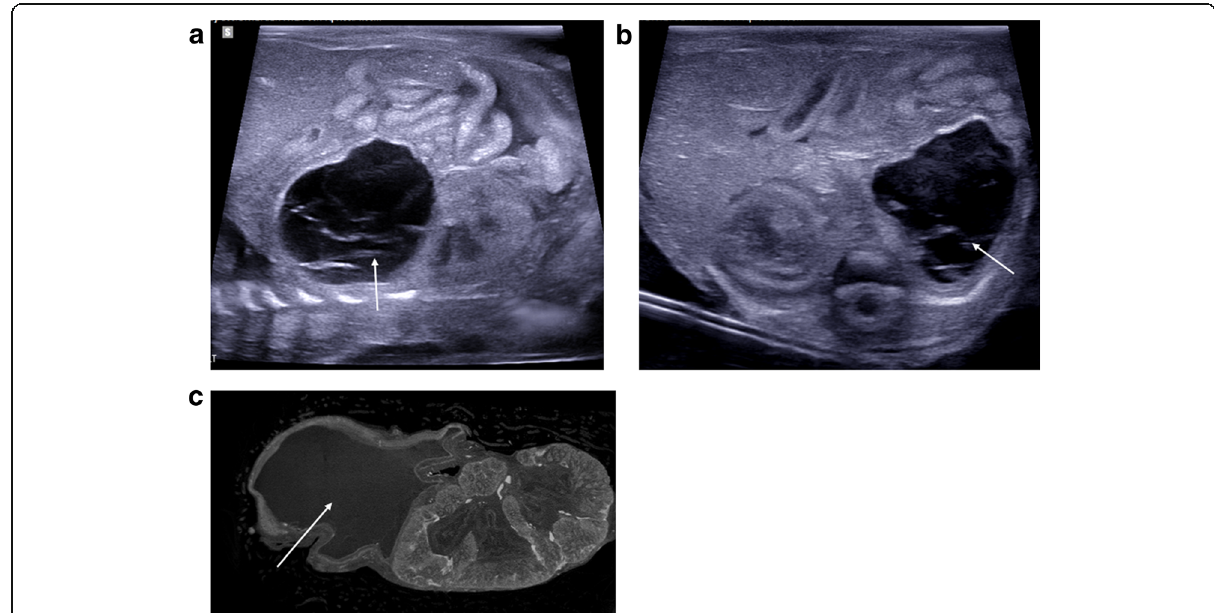
Fig. 15 Left adrenal haemorrhage in a foetus at 18 weeks gestation, following termination of pregnancy for megalourethra. The post-mortem ultrasound images of the left kidney in sagittal section ( a ) and of the adrenal glands in transverse plane ( b ) were obtained 6 days after delivery. There is a large septated, cystic mass in the left suprarenal space (solid arrows), better depicted on the sagittal contrast enhanced micro-CT imaging ( c ) of the extracted left kidney. The findings were in keeping with a small haematoma from in utero adrenal haemorrhage